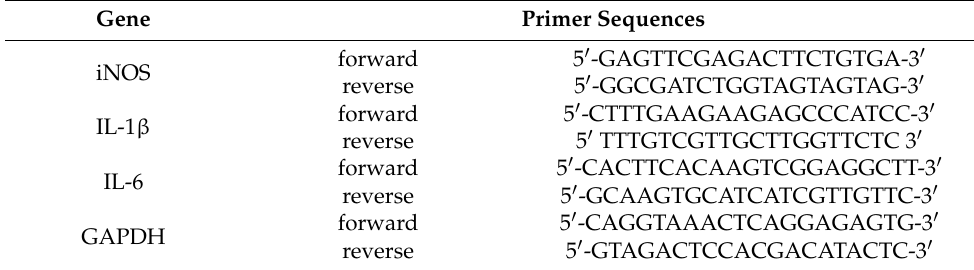
Table 3. Primer sequence used to detect cytokine gene expression. Gene Primer Sequences